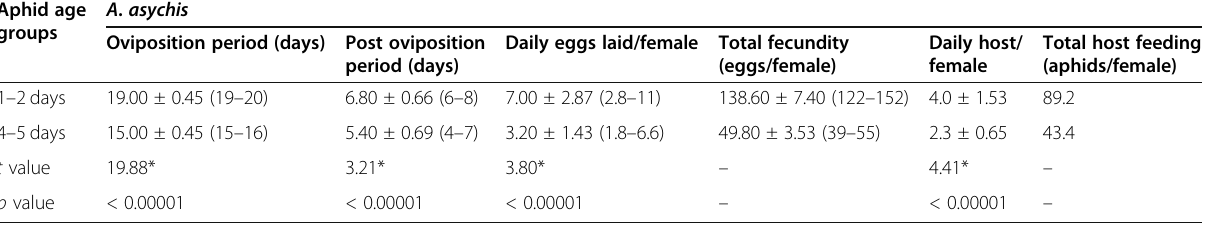
Table 7 Developmental parameters (mean ± SE) of A . asychis females parasitizing different age groups of M . persicae Aphid age groups